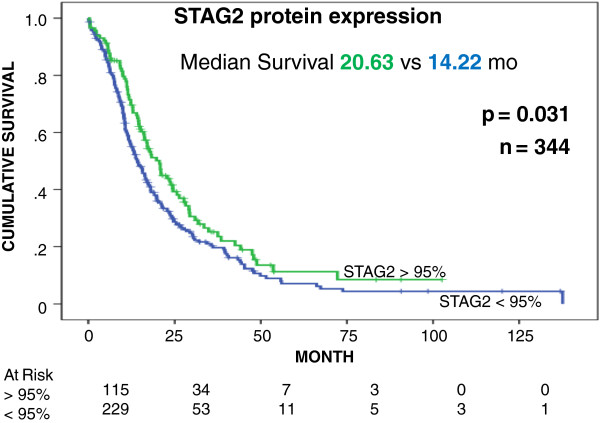
STAG2 expression and overall survival in patients with PDA. Tissue microarray (TMA) analysis of STAG2 protein expression in PDA samples from 344 patients. Cumulative survival (y-axis) of patients with intact versus deficient STAG2 expression levels is plotted versus time (x-axis). Mo, months.